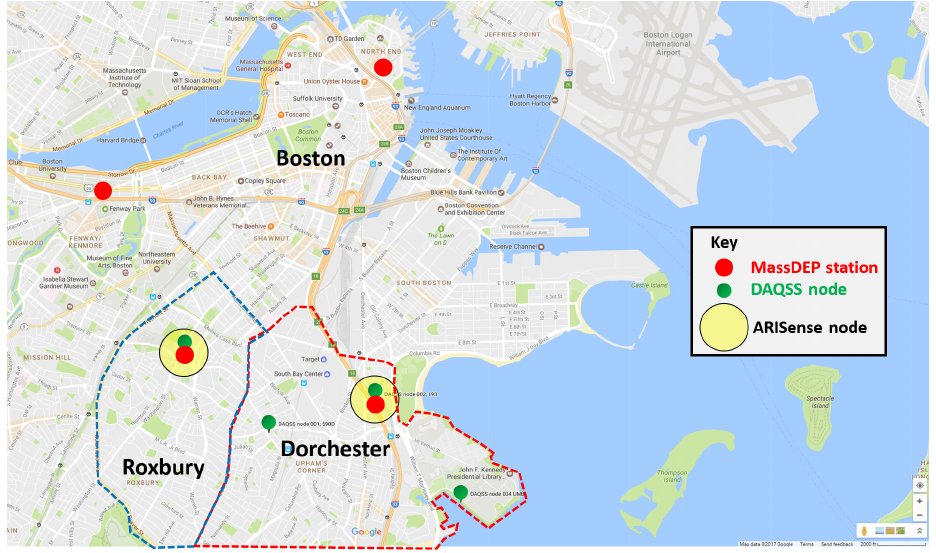
Figure 2. Map showing the locations of the two ARISense systems (yellow circles) and the four Boston metropolitan area DEP monitoring stations (red circles). The two ARISense systems were co-located with reference stations at the Harrison Avenue site (in Dudley Square, Roxbury) and Von Hillern Street site ( ∼ 35 feet from I-93 north) in Dorchester. The data presented in this paper were obtained from the Dudley Square location, an urban neighborhood site, primarily impacted by local combustion sources and vehicles operating on secondary routes in close proximity to the area. Green markers are shown to indicate the positions of four additional sensor nodes deployed as part of the Dorchester Air Quality Sensor System (DAQSS) project, which predated the development of